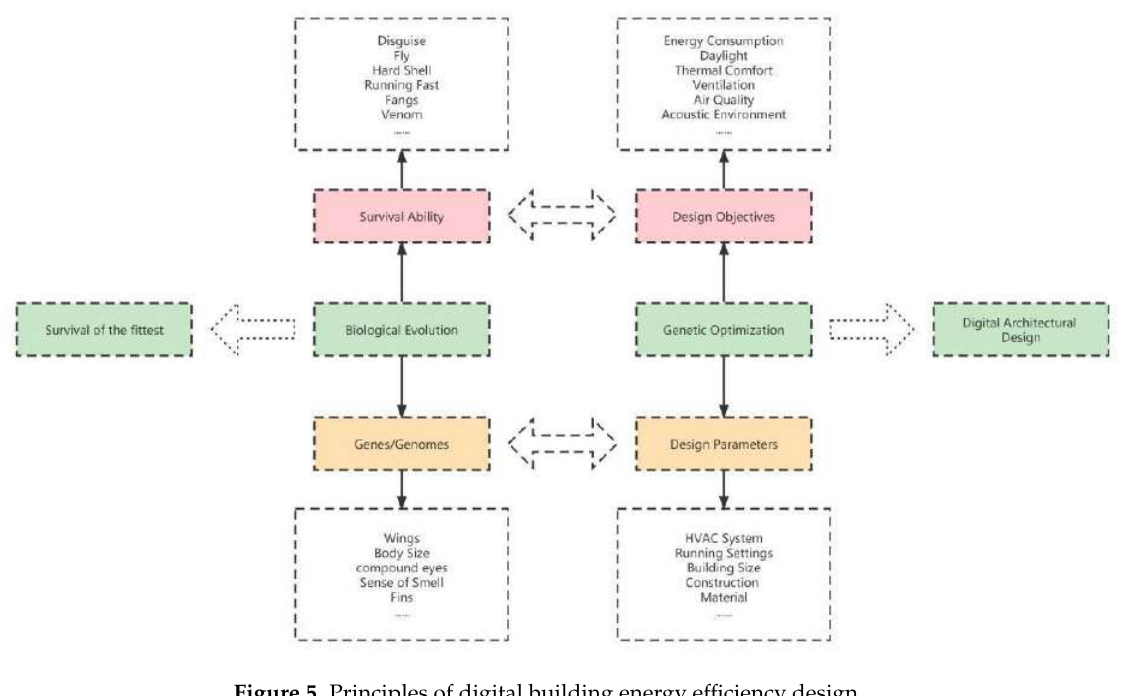
Figure 5. Principles of digital building energy efficiency design.